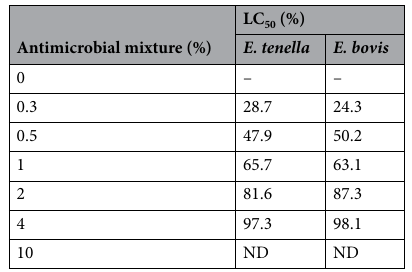
Table 2. Lethal concentration 50 (LC 50 ) at which the natural antimicrobial mixture (AG) reduced the number of E. tenella and E. bovis oocysts by more than 50%. Each sample represents a mean of triplicate (n = 3) assays. ND not